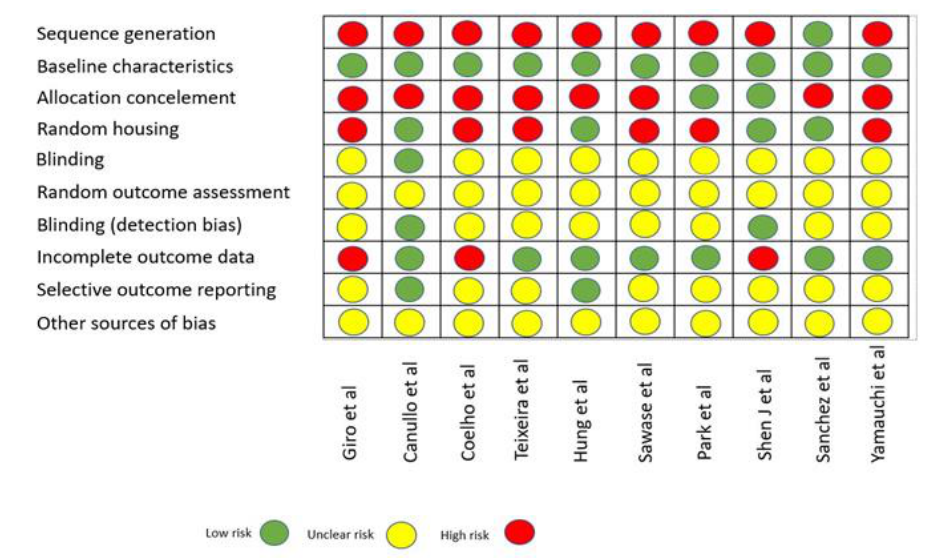
Figure 2. Quality assessment of included animal studies.